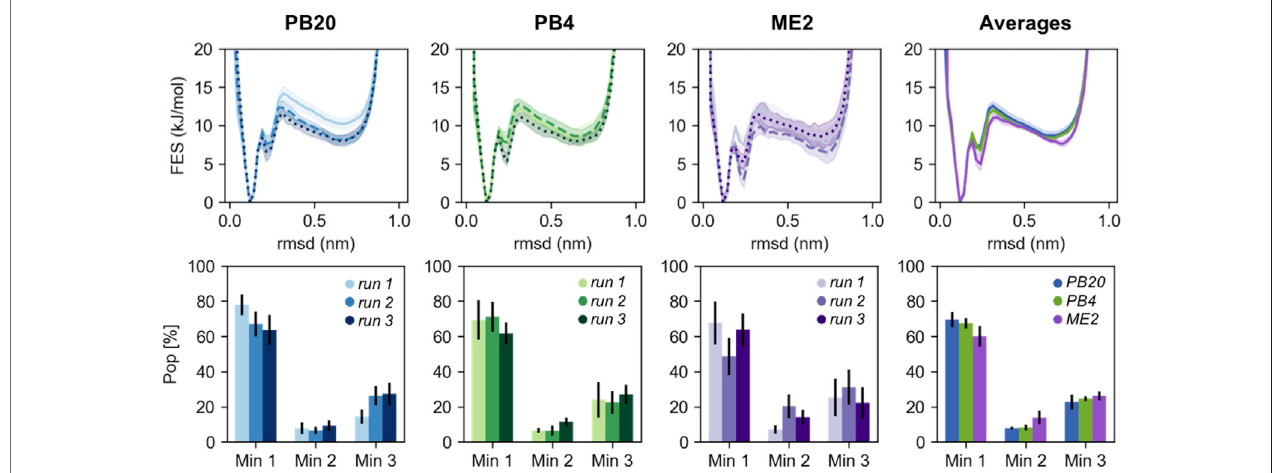
FIGURE 2 | The RMSD free energies (top panels) and the population of the three main chignolin minima (bottom panels) are represented for different sets of simulations (PB20 in blues, PB4 in greens, ME2 in violets shades). The different shades indicate each of the runs of the triplicates and the errors are estimated via block- average analysis. In the rightest panels are reported the averages computed over the triplicates for each set of simulations; here the errors are determined as standard errors over the triplicates as described in the main text. In all the pictures the free energies are shifted to set their minimum to